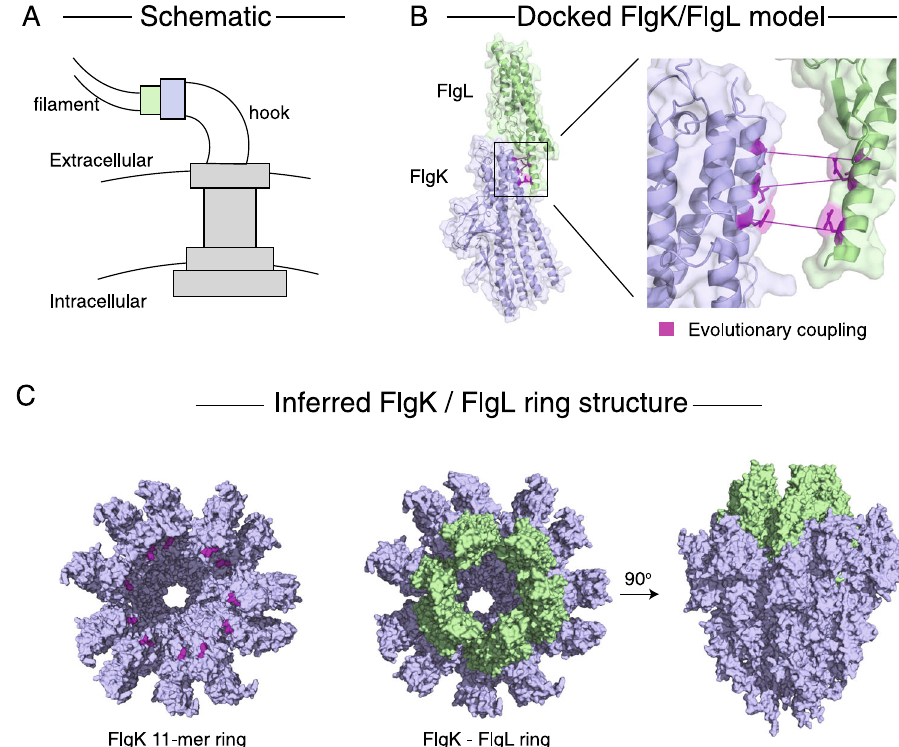
Fig. 4 Model of the fl agellar hook- fi lament junction. A Schematic of the orientation of the bacterial fl agellum. The proteins FlgL (green) and FlgK (blue) form two rings which create the junction between the hook and fi lament of the fl agellum 24 . B Docked model of FlgL and FlgK using evolutionary couplings. PDB structures of homologous proteins from Salmonella typhimurium were used in docking (PDB IDs 2D4Y [https://www.rcsb.org/structure/2D4Y], and 2D4X [https://www.rcsb.org/structure/2D4X], respectively). Predicted interface residues are highlighted in purple. C A previously inferred model of the FlgK ring from Campylobacter jejuni 24 was used to infer the structure of the entire hook- fi lament junction. Evolutionary coupled residues (purple) show the interface for FlgL ring insertion into the FlgK ring. By aligning our docked model to the C. jejuni ring, we show that an 11-mer ring of FlgL fi ts inside the FlgK